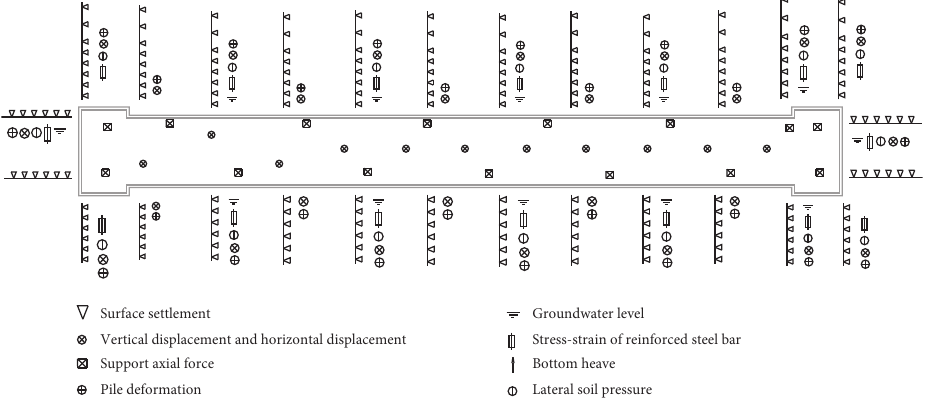
Figure 4: Monitoring